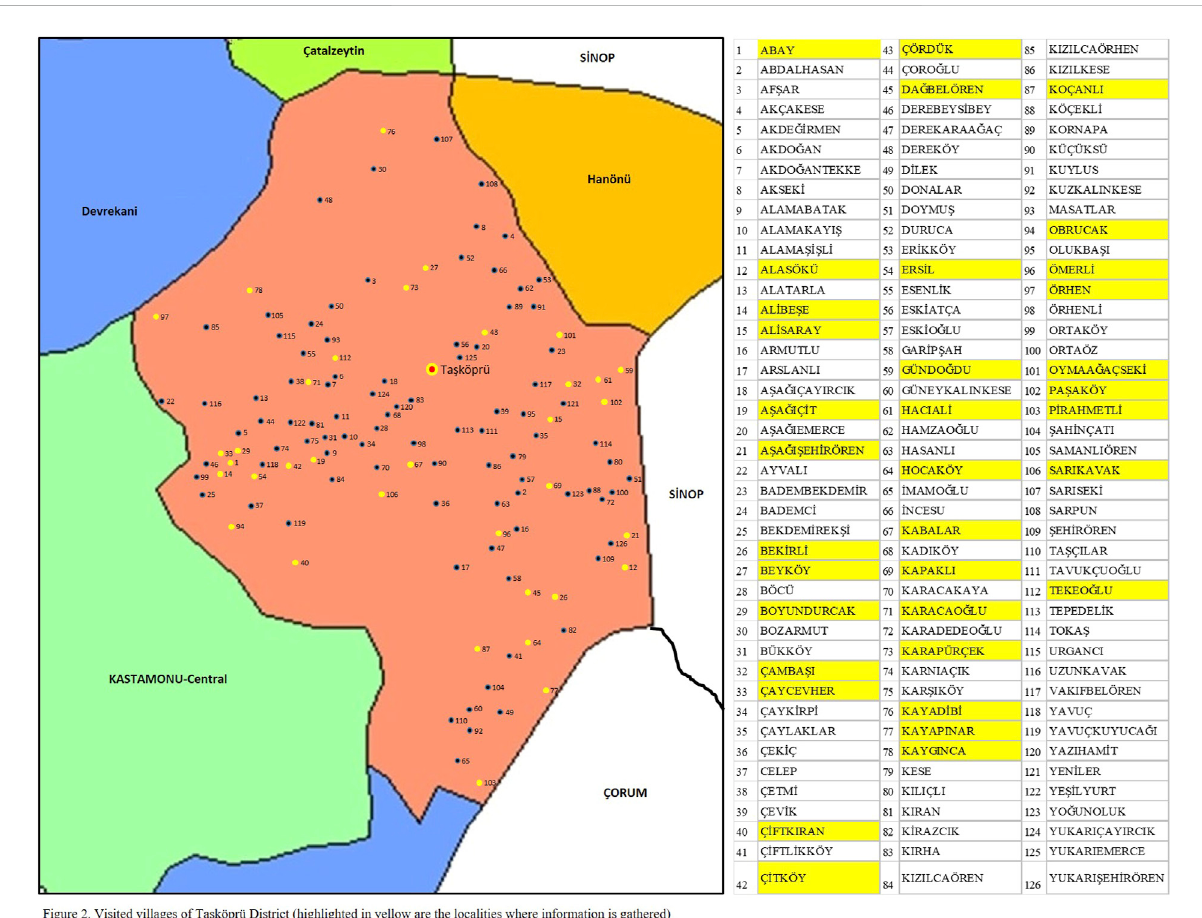
FIGURE 2 Visited villages of Ta ş köprü District (highlighted in yellow are the localities where information is